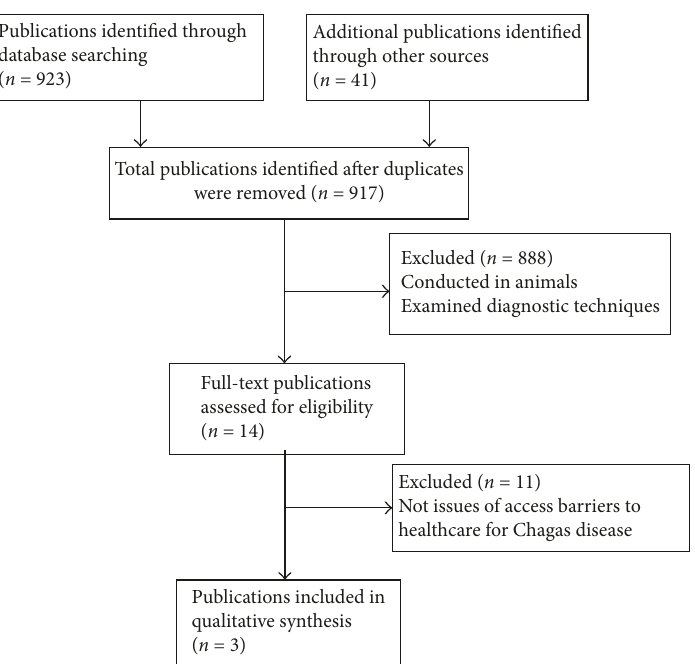
Figure 1: PRISMA flow diagram describing the review process and study selection.